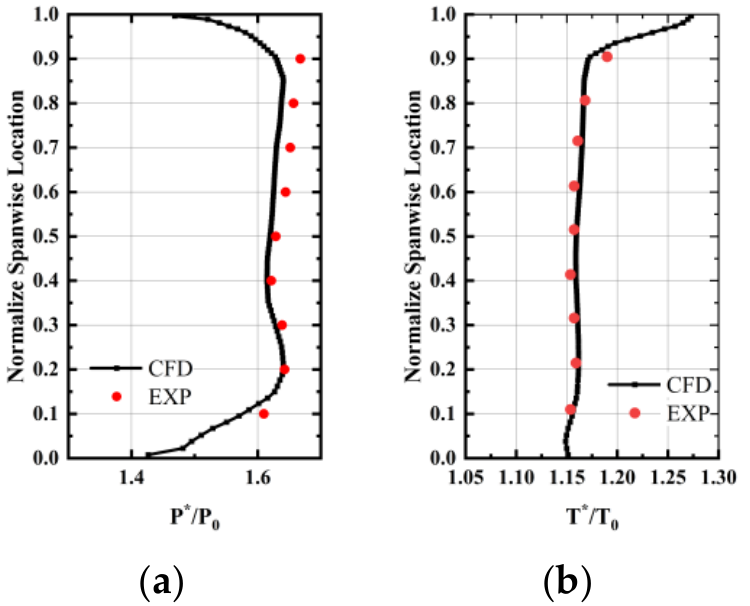
Figure 5. Comparison of the radial distribution downstream of the rotor alone at PE. ( a ) Total pressure radial profile; ( b ) total temperature radial profile.